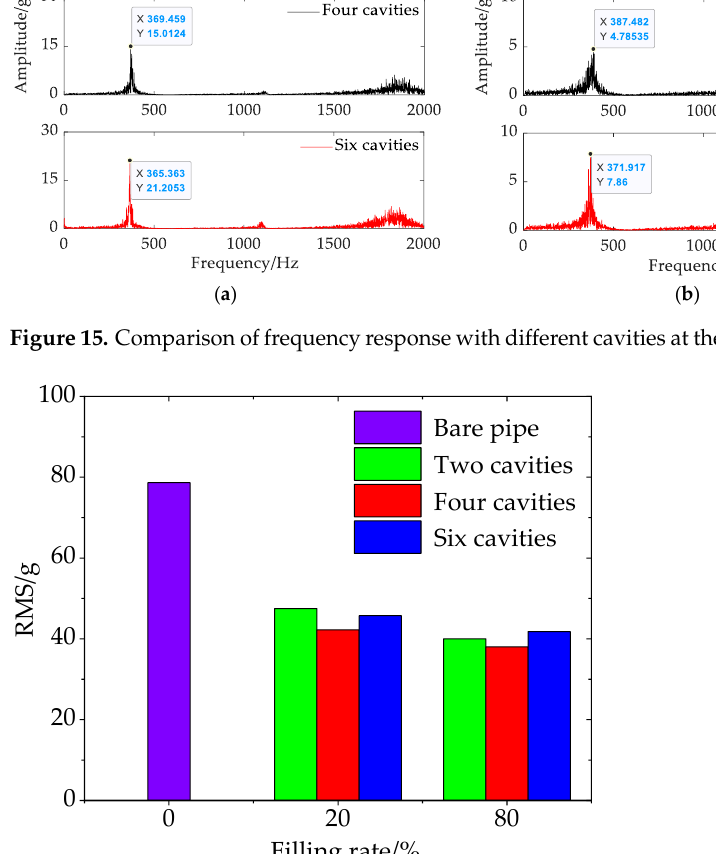
Figure 16. Influence of damper cavity on damping effect.